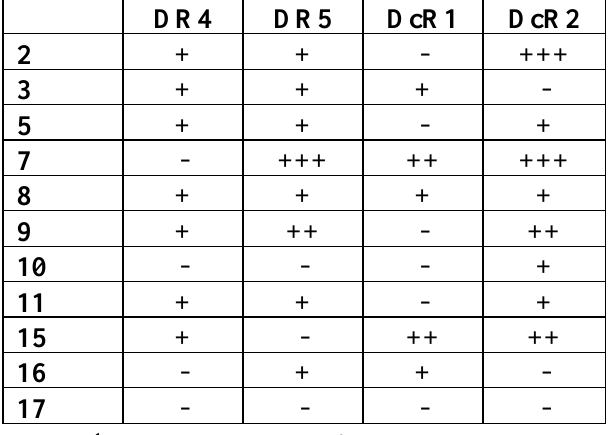
Table 3. TRAIL receptor cell surface expression in primary AML